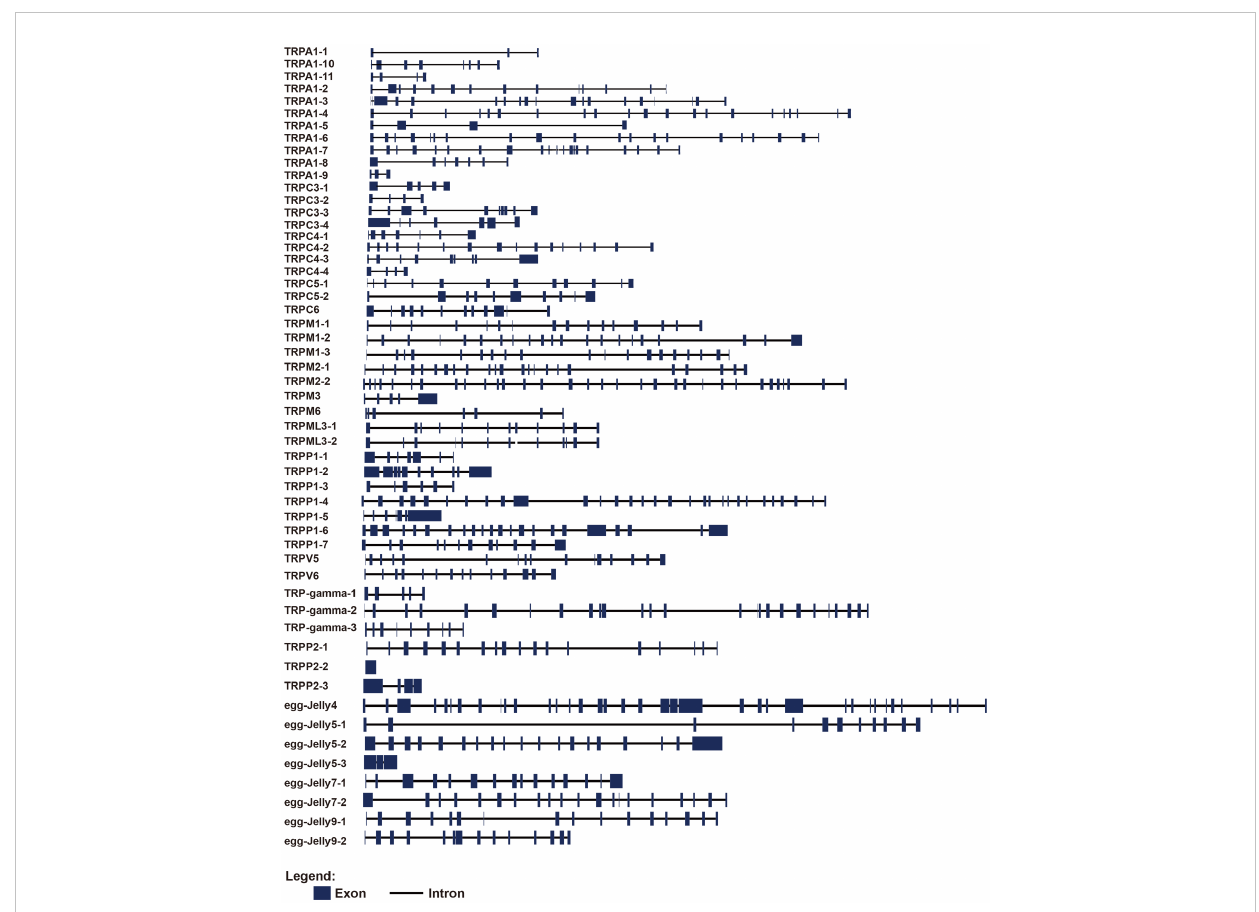
FIGURE 2 Gene structures of TRPs in A. japonicus . The blue square represents the exon region and the black line represents the